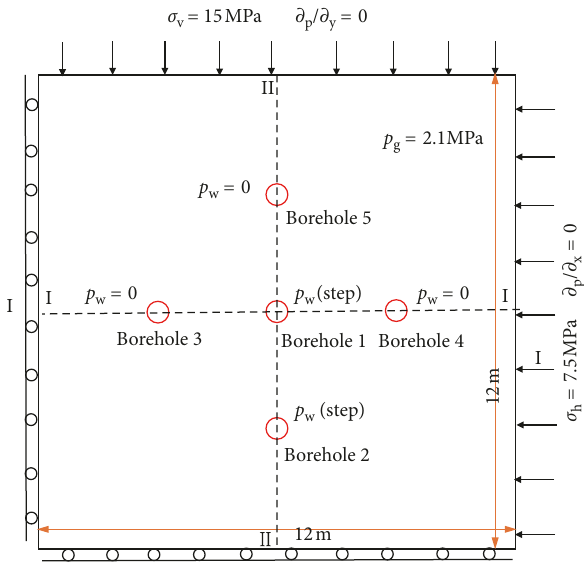
Figure 11: Geometry and definite conditions of numerical